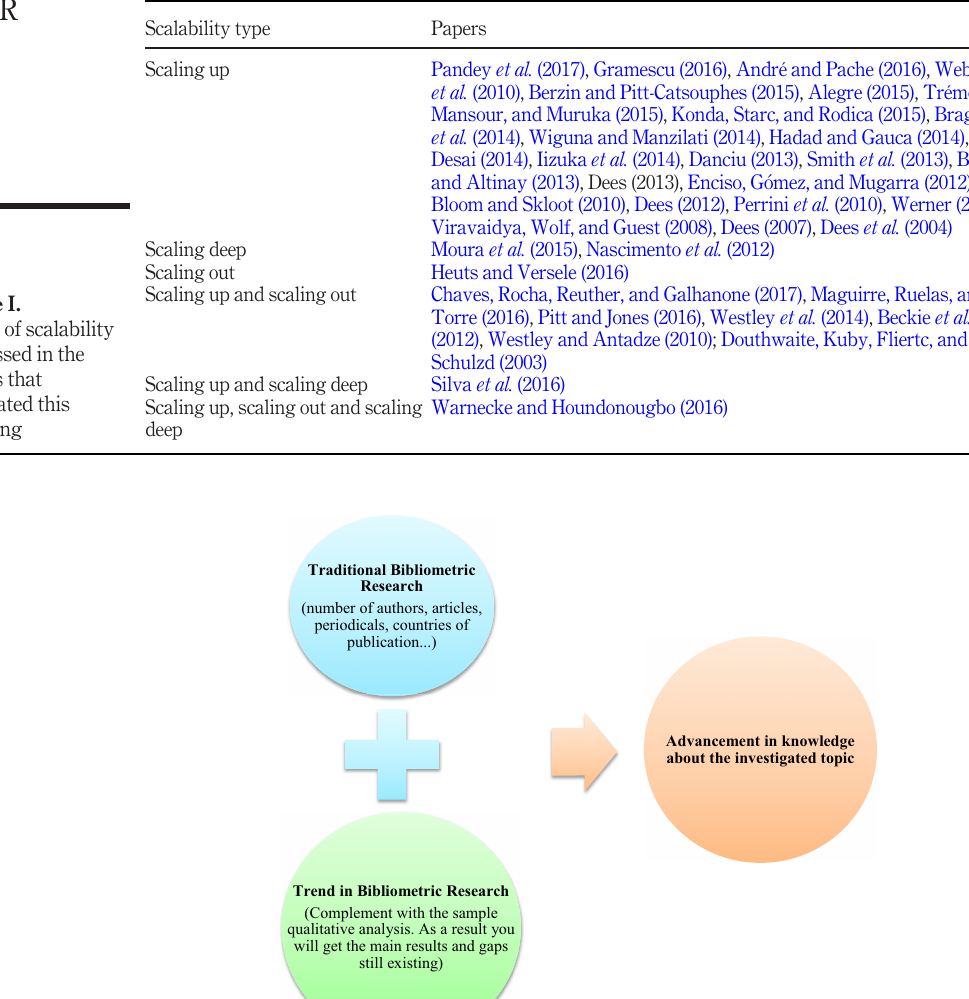
Figure 4. Model of